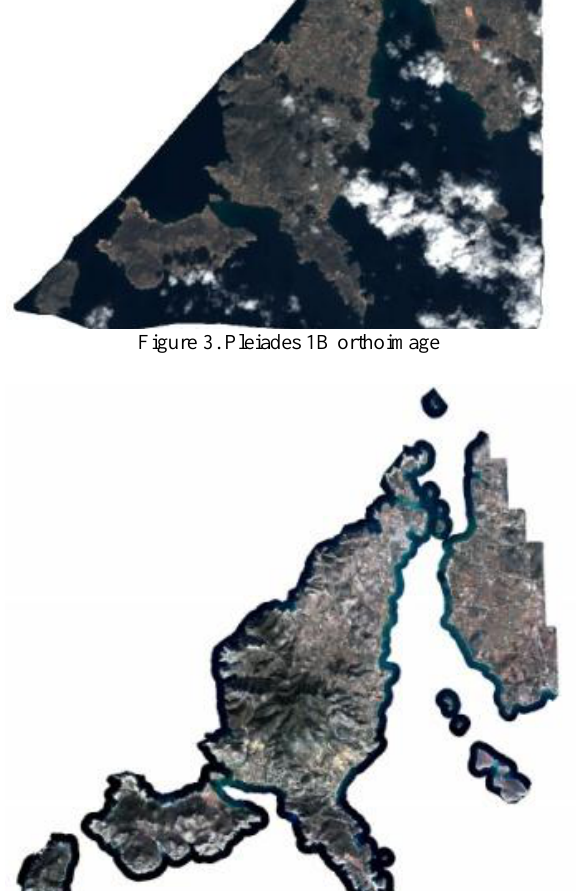
Figure 2. Ground control points and check points used for Pleiades 1B data